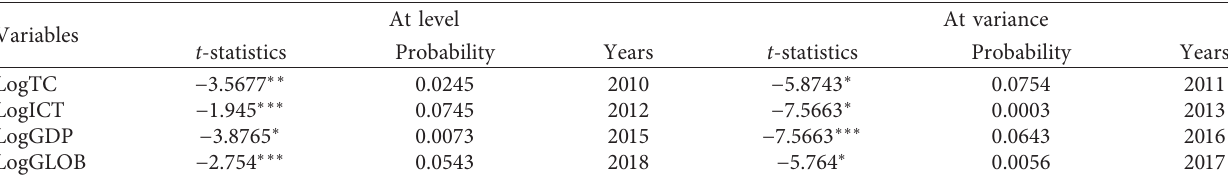
Table 2: Outcomes of Zivot-Andrews (ZA) test.